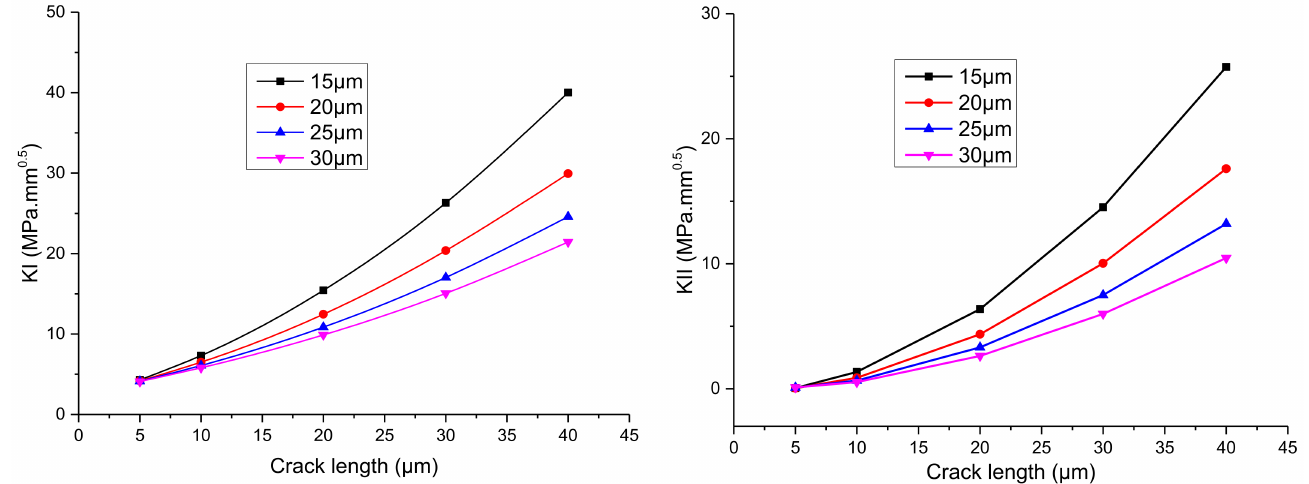
Figure 9. The relationship between the stress intensity factor K I of the interfacial crack tip and solder thickness under different solder